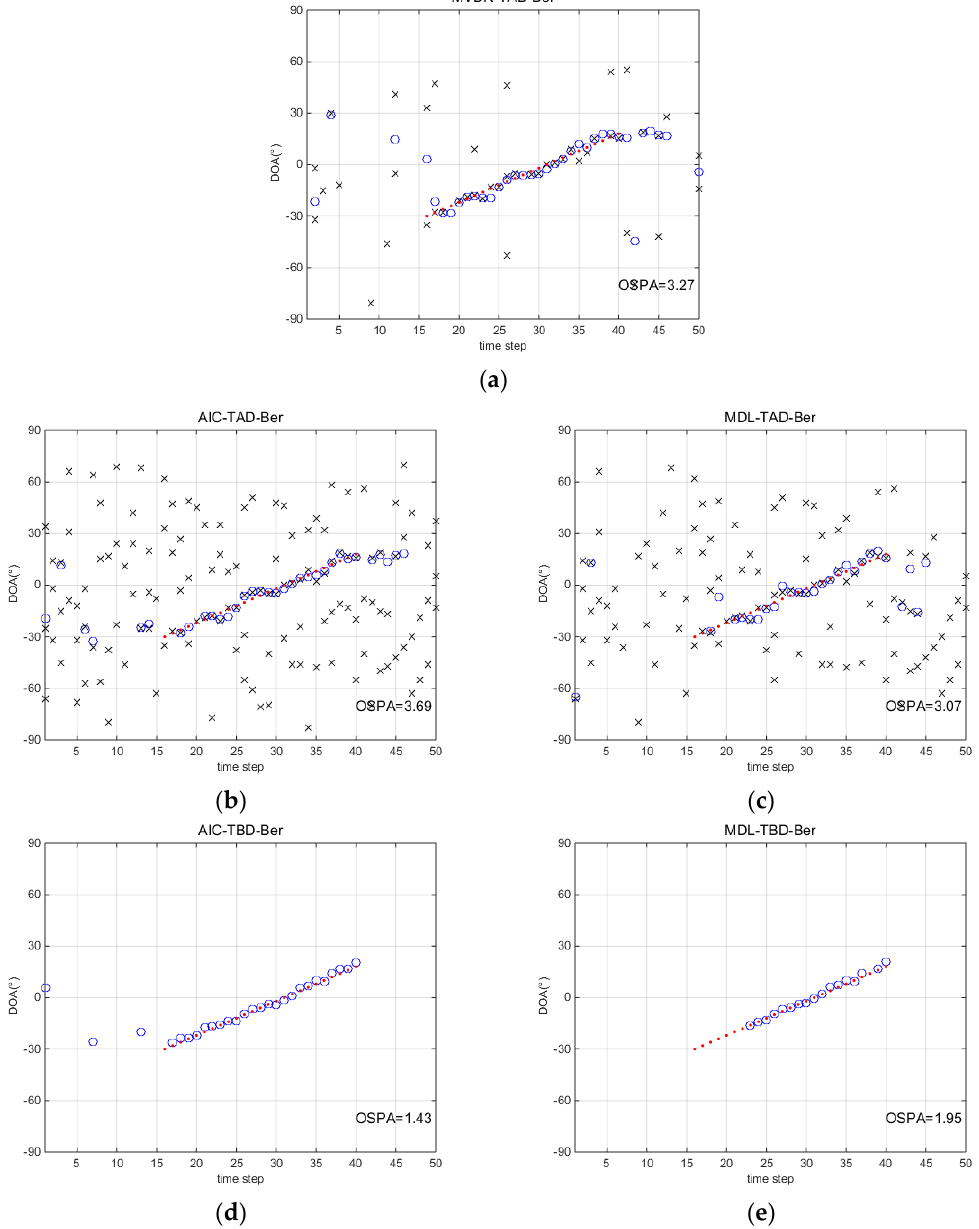
Figure 4. DOA tracking results with SNR = − 14 dB and snapshots N = 200. ( a ) MVDR-TAD-Ber; ( b ) AIC-TAD-Ber; ( c ) MDL-TAD-Ber; ( d ) AIC-TBD-Ber; ( e ) MDL-TBD-Ber.